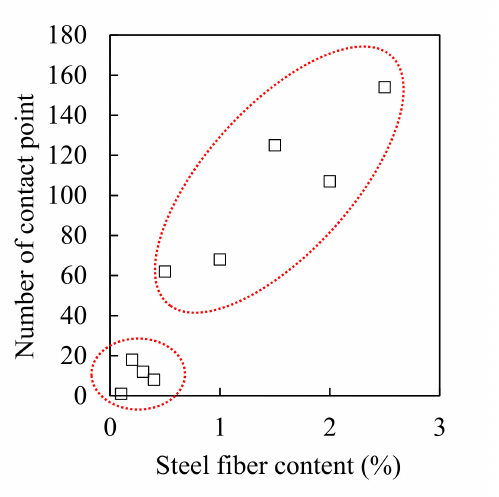
Figure 11. Plot of the number of contact points as a function of steel fiber content.